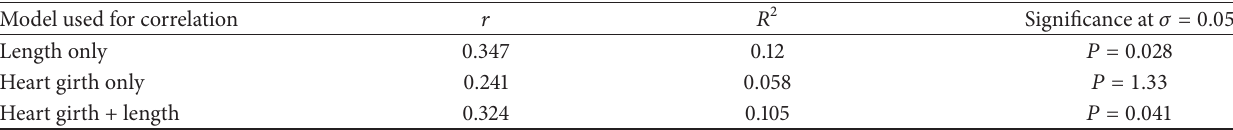
Table 5: Correlation between prediction model and 40 pigs from neighboring farms.